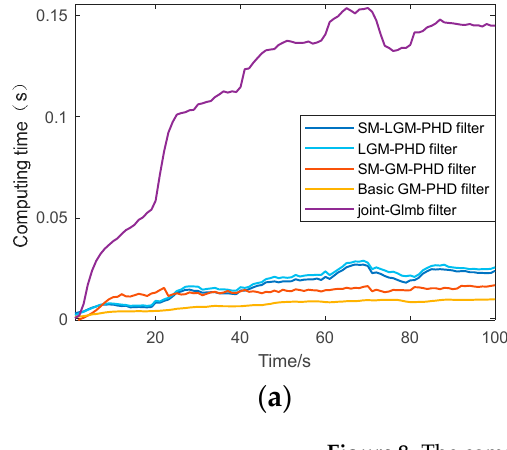
Figure 8. The computation time of different filters for 100 sample runs at T s = 1 s ( T i = 2 ms, λ = 104, p D , k = 0.8) ( a ) and T s = 2 s ( T i = 4 ms, λ = 52, p D , k = 0.96) ( b ) in example 1 (CV motion model).